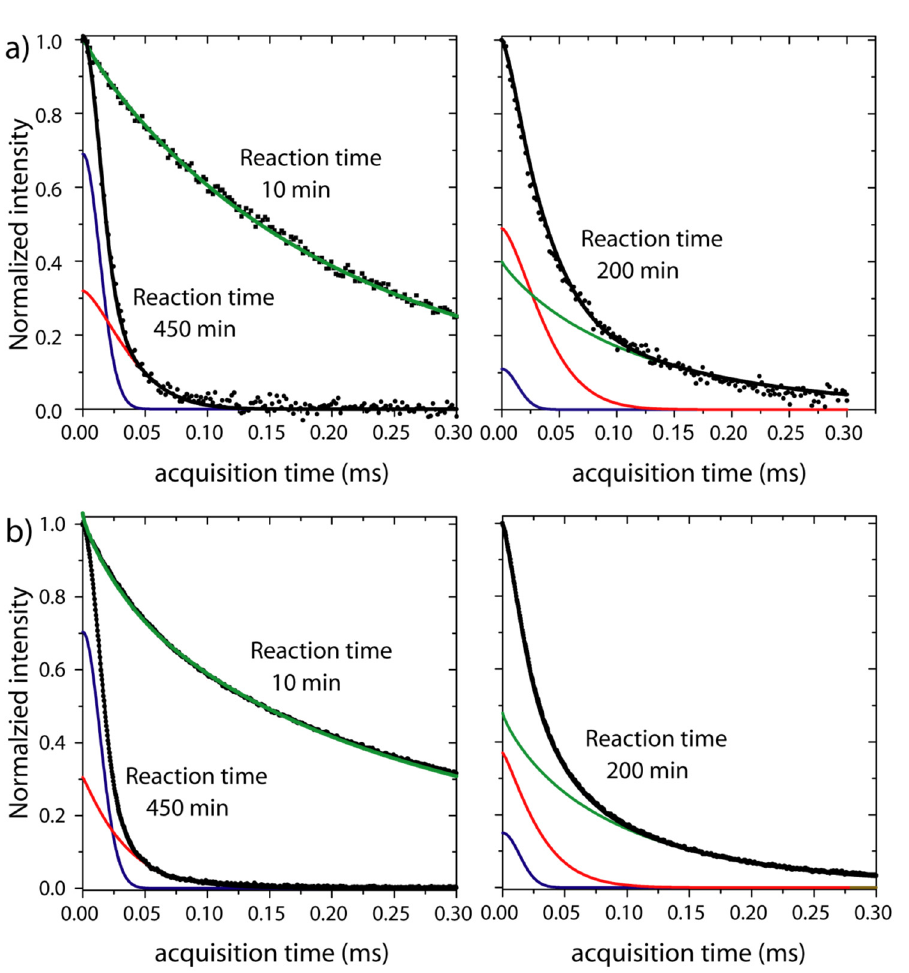
Figure 2. Example of deconvolution of dipolar echoes signals obtained with mixed-MSE ( a ) and RK-ROSE ( b ) pulse sequences using Equation (1). The signals shown in ( a , b ) were acquired at the indicated reaction times during the cure of the epoxy resin at 293 K. Note that the differences in the signal to noise between the mixed-MSE and RK-ROSE are due to the differences in the number of scans and echo times as shown in the methods section. Both pulse sequences have similar efficiencies at this set-up